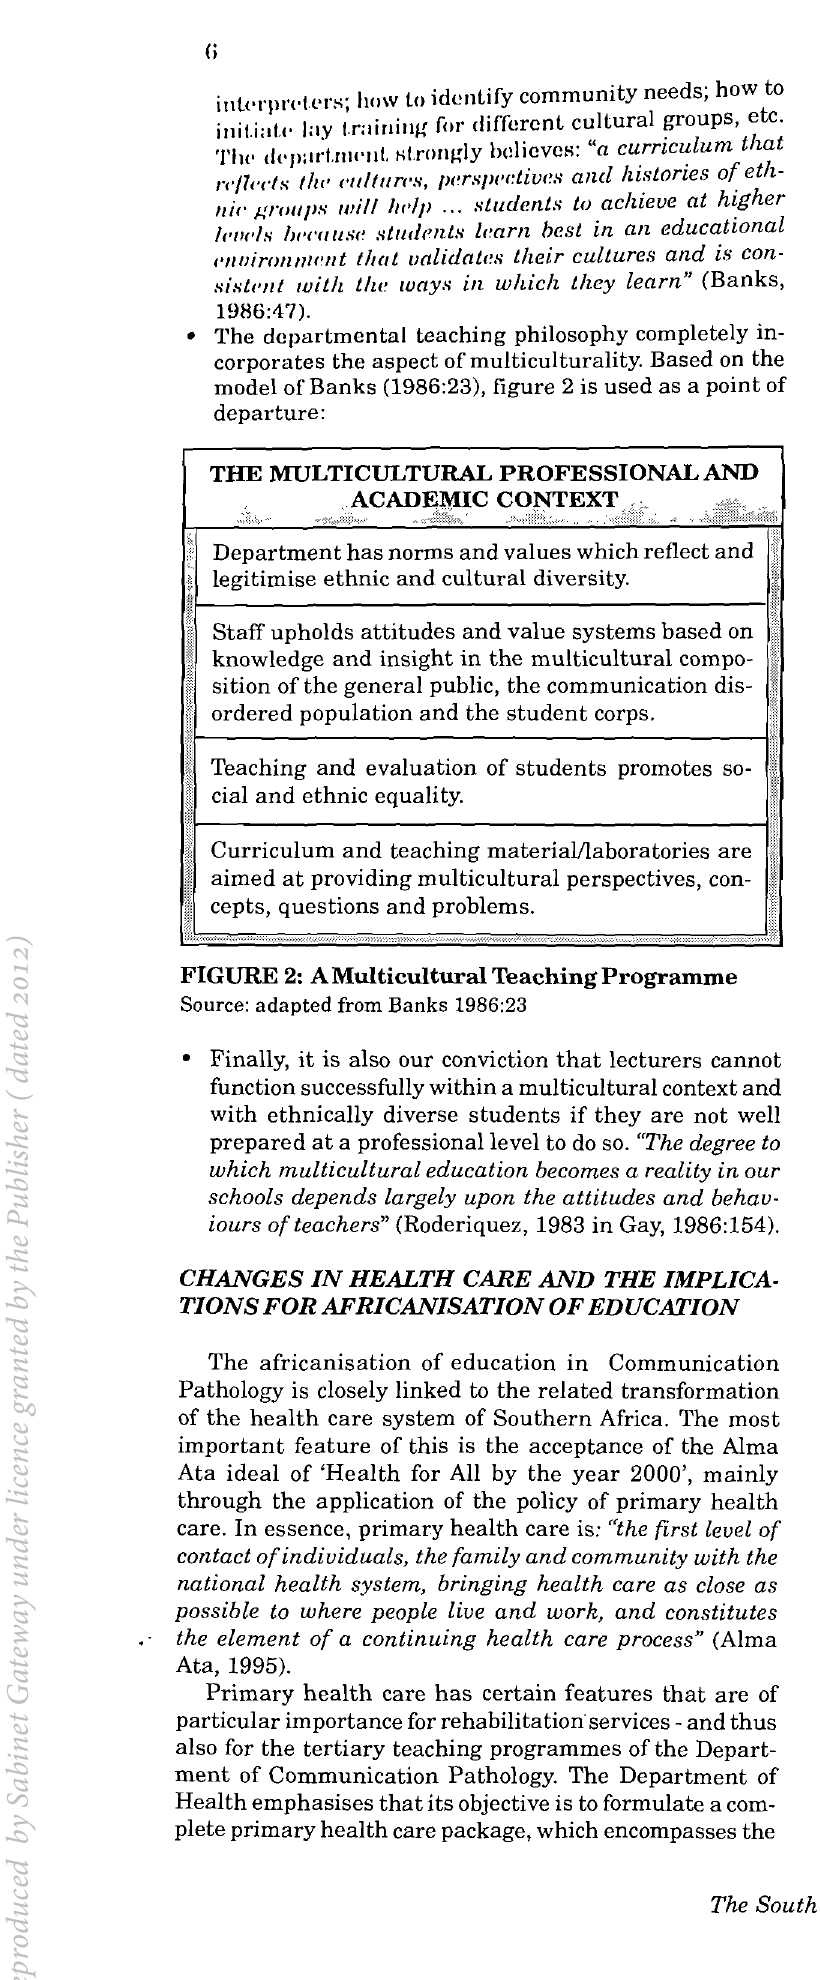
FIGURE 2: A Multicultural Teaching Programme Source: adapted from Banks